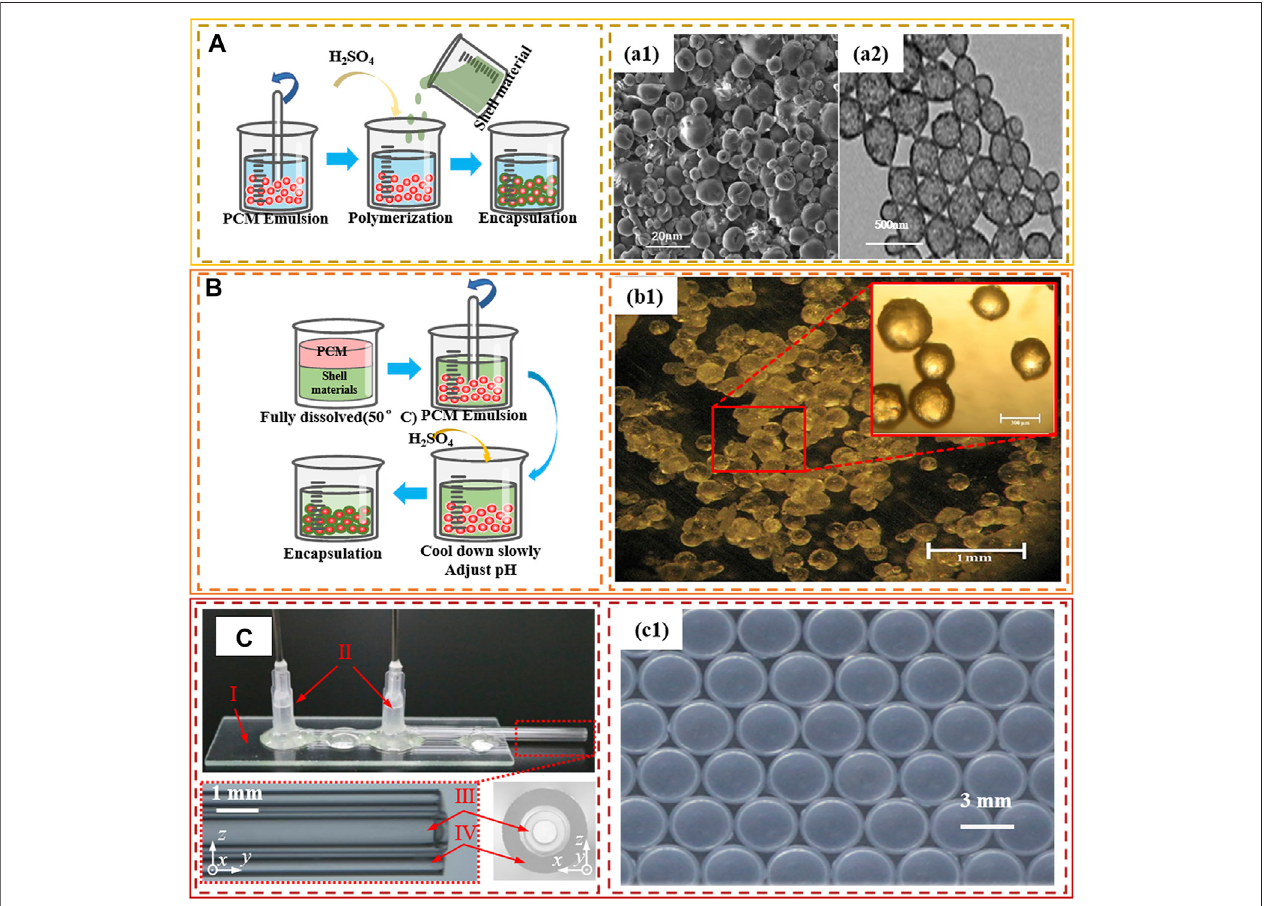
FIGURE 1 | Encapsulation methods: (A) polymerization, (a1) and (a2) are EPCM produced by in situ polymerization (Srinivasaraonaik et al., 2020) and interfacial polymerization(ZhaoandLuo,2022),respectively, (B) coacervation (Malekipirbazarietal.,2014), (C) micro fl uidicEPCM production(I:glassslide,II:dispensingneedles, III: inner capillary, IV: outer capillary) (Hao et al., 2022).